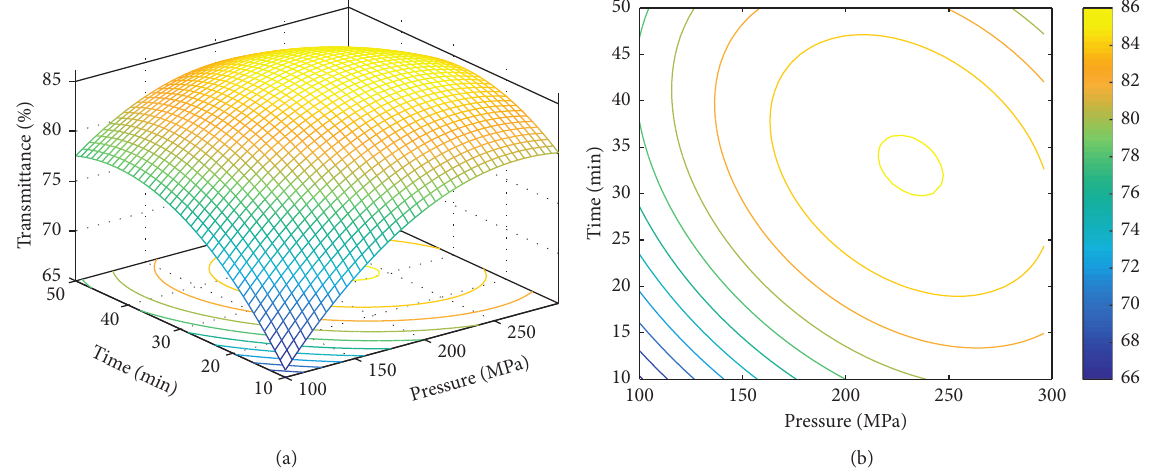
Figure 7: The optimal transmittance surface depends on the time and pressure.